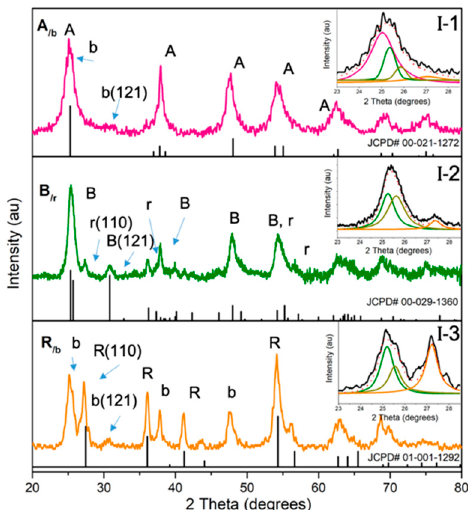
Figure 1. XRD patterns of aqueous-synthesized mixed-phase nanoTiO 2 materials; anatase major, A / b , brookitemajor, B / r andrutilemajorphase, R / b .